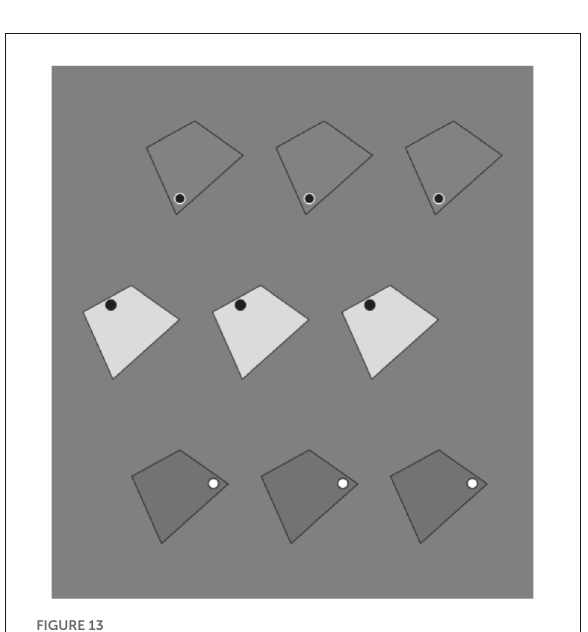
FIGURE13 Rhomboids (first row), trapezoids (second row), a further kind of quadrilateral (third